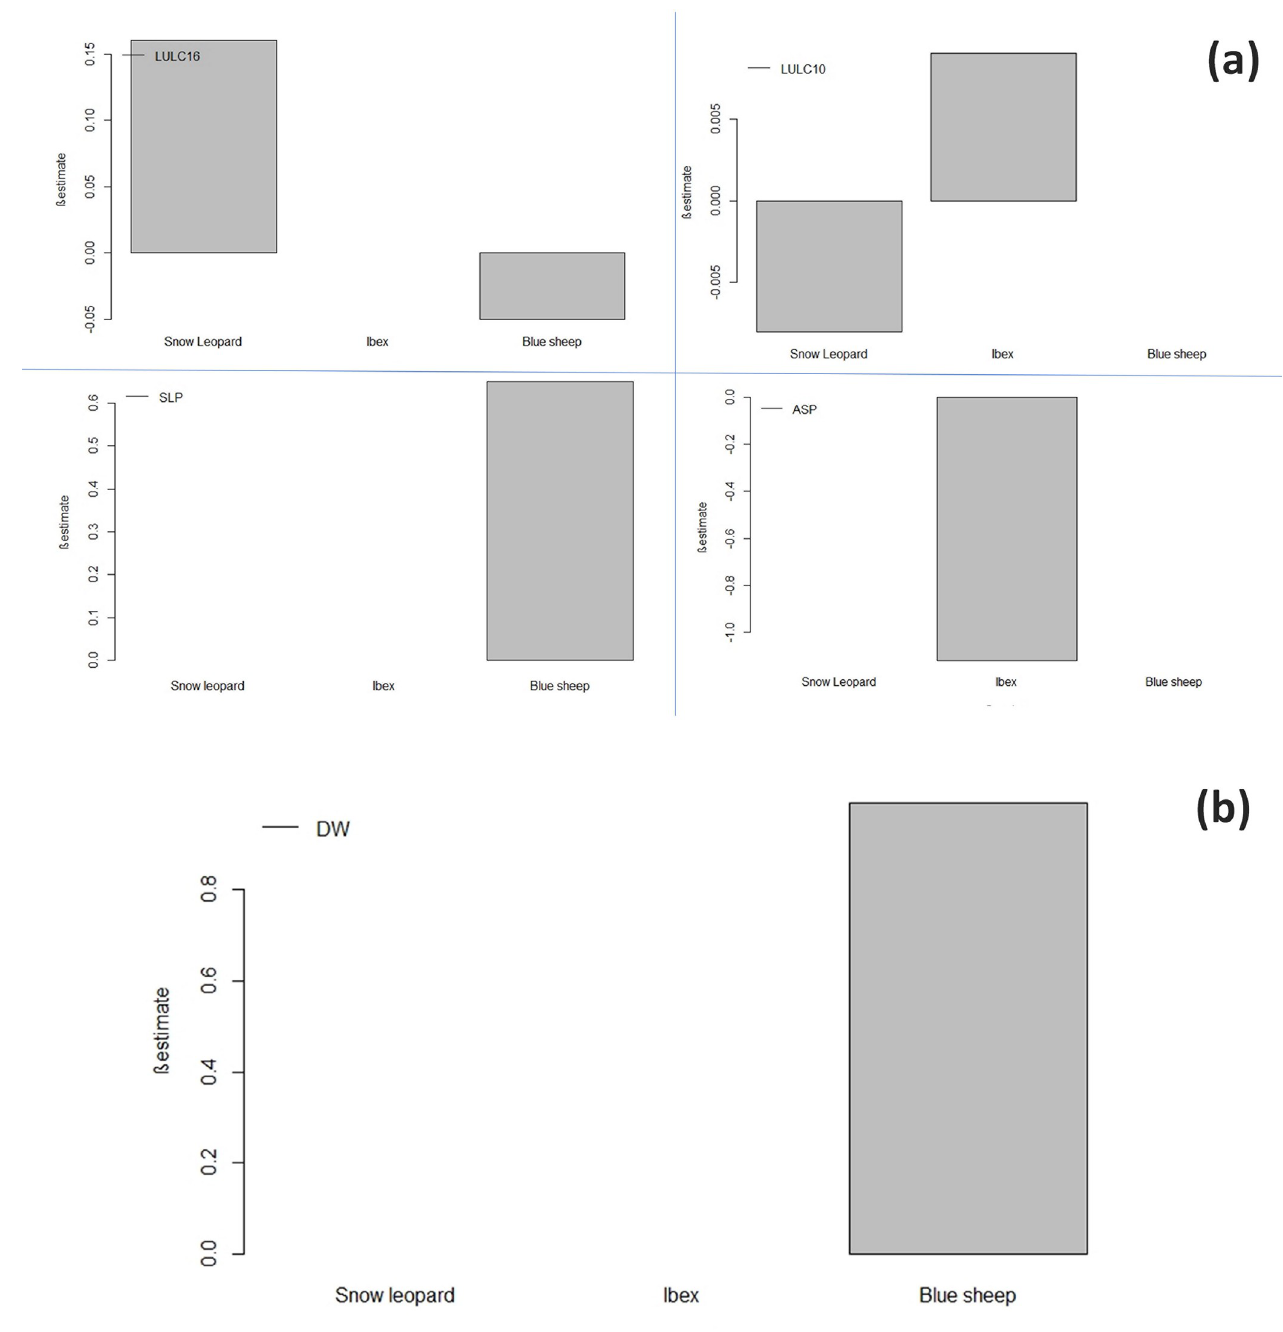
Fig 3. a and b. Influence of habitat covariates retained in top models on the occupancy of snow leopard and its prey species. Variables retained are LULC16- barren area, LULC10- grasslands/herbaceous annuals, ASP-aspect, SLP-slope &DW-distance to